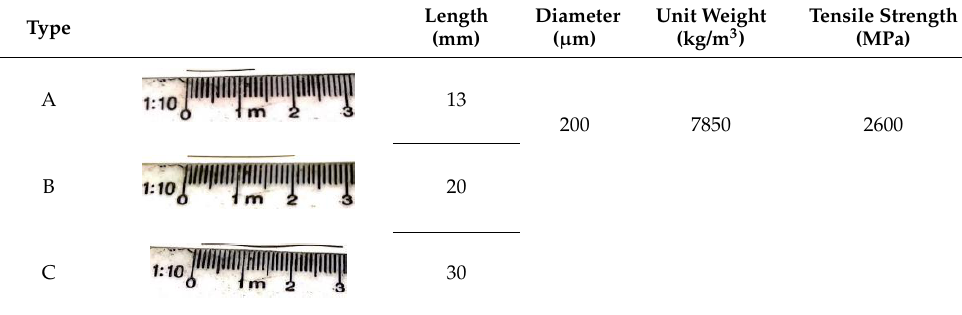
Table 3. Physicomechanical properties of microsteel fibers.